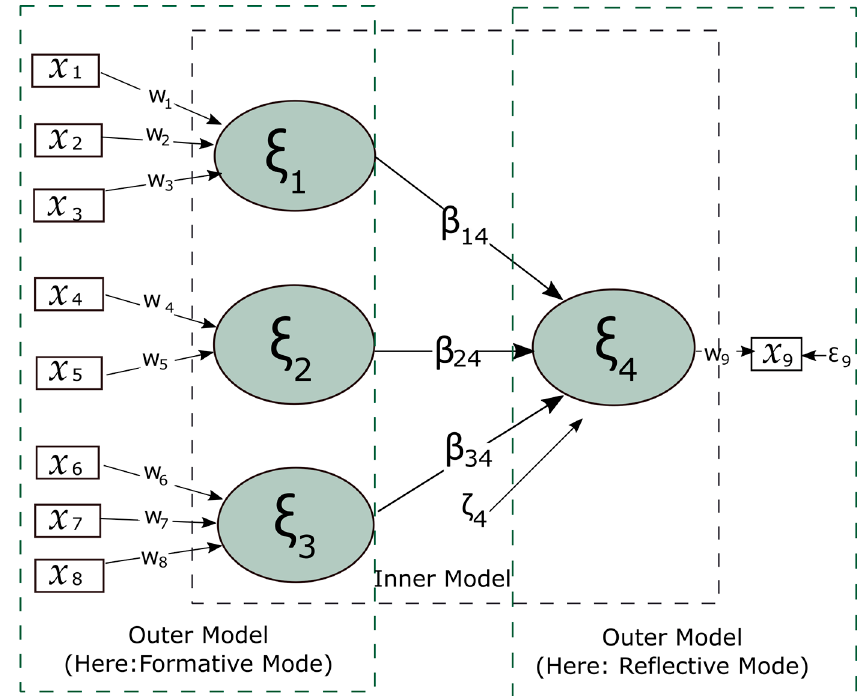
Figure 2. Example of a typical SEM Partial Least Squares (PLS) Path Model. Adjusted from Henseler et al. [58] and Hair et al. [59]. χ x : manifested variable; w: outer loading; ξ : latent variable; β : path coefficient; ζ : inner model residual; ε : residual.